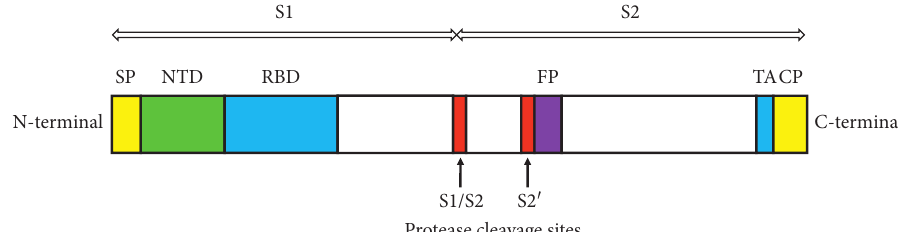
Figure 2: Schematic diagram of the domain structure of SARS-CoV-2 spike (S) protein. SP � signal peptide, NTD � N-terminal domain, RBD � receptor binding domain, FP � fusion peptide, TA � transmembrane anchor, and CP � cytoplasmic domain